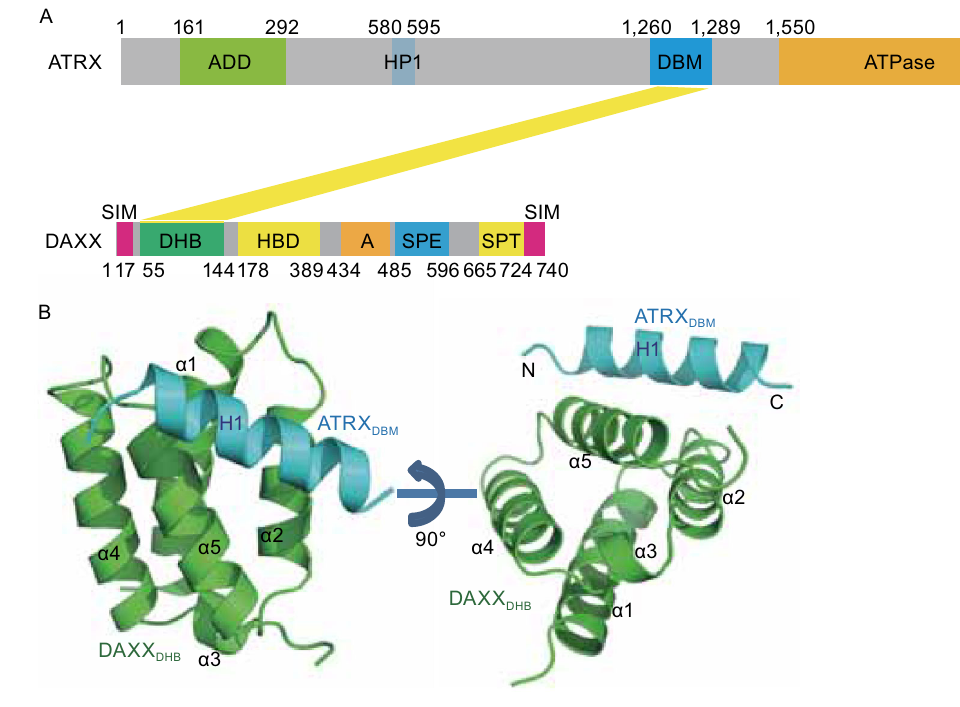
Figure 1. The structure of the DAXX DHB -ATRX DBM complex . (A) Domain organization of the ATRX and DAXX. ADD, ATRX- DNMT1-DNMT1L domain; HP1, HP1-binding motif; DBM, DAXX binding motif; ATPase, ATPase domain; SIM,